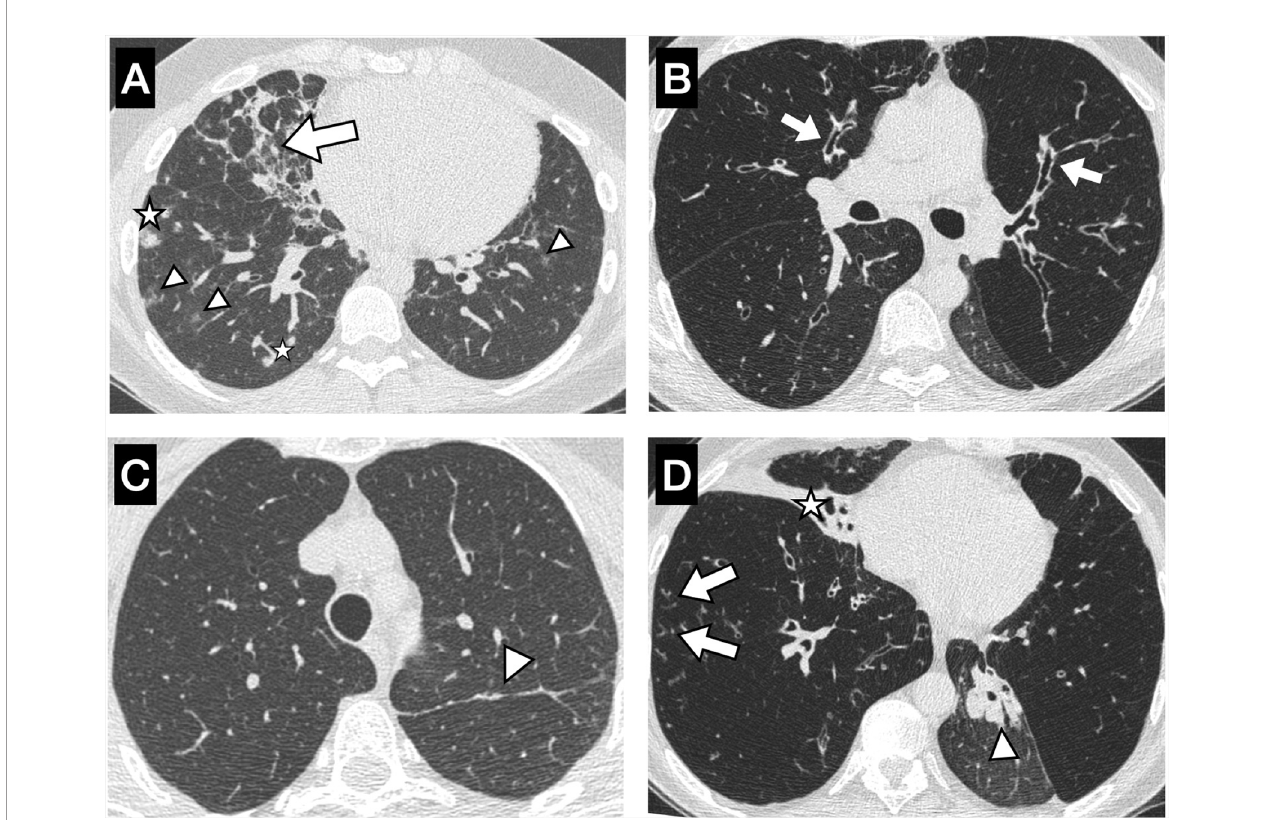
FIGURE 2 | Chest CT from 4 different patients of our study with some of the evaluated parameters. (A) GLILD patient with multiple bilateral ground-glass nodules <5 mm (arrowheads), solid nodules (stars), and mixed (in fl ammatory and fi brotic) lines (arrow). (B) Non-GLILD patient with diffuse mild bronchial wall thickening and mild bronchiectasis (arrows) with air trapping predominantly in theupper lobes andpartial atelectasisofleftlower lobe. (C) Non-GLILD patientwith linear parenchymal band inthe leftupper lobe(arrowhead). (D) Non-GLILD patientwith mucus plugging in large airwaysof the leftlower lobewith >50% atelectasis of the same lobe(arrows), complete atelectasis of the middlelobe(star), tree in bud patternin the right lower lobe(arrows),and air trapping on the leftupper andright lower lobes. GLILD, granulomatous – lymphocyticinterstitial